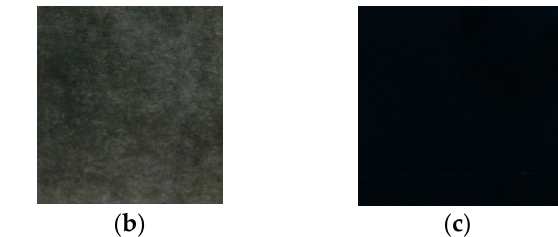
Figure 1. Optical images of chitosan-based films containing 0, 0.5, and 3 wt.% of SWCNT (( a ), ( b ), and ( c ), respectively).